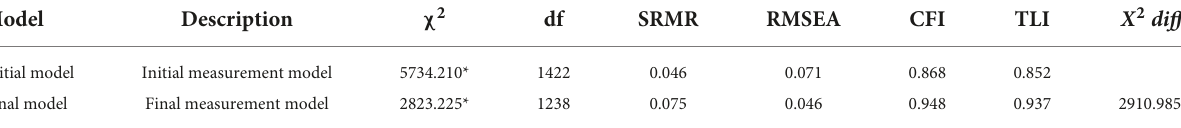
TABLE 3 Fit indices for resilience, anxiety, and depression measurement model.